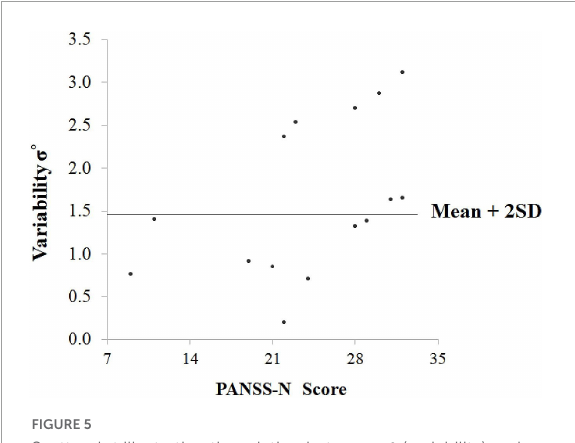
FIGURE5 Scatterplot illustrating the relation between σ ◦ (variability) and PANSS-N scores for SCZ. The previously calculated upper limit for the reference range of σ ◦ values in controls (mean + 2SD) is also included in the